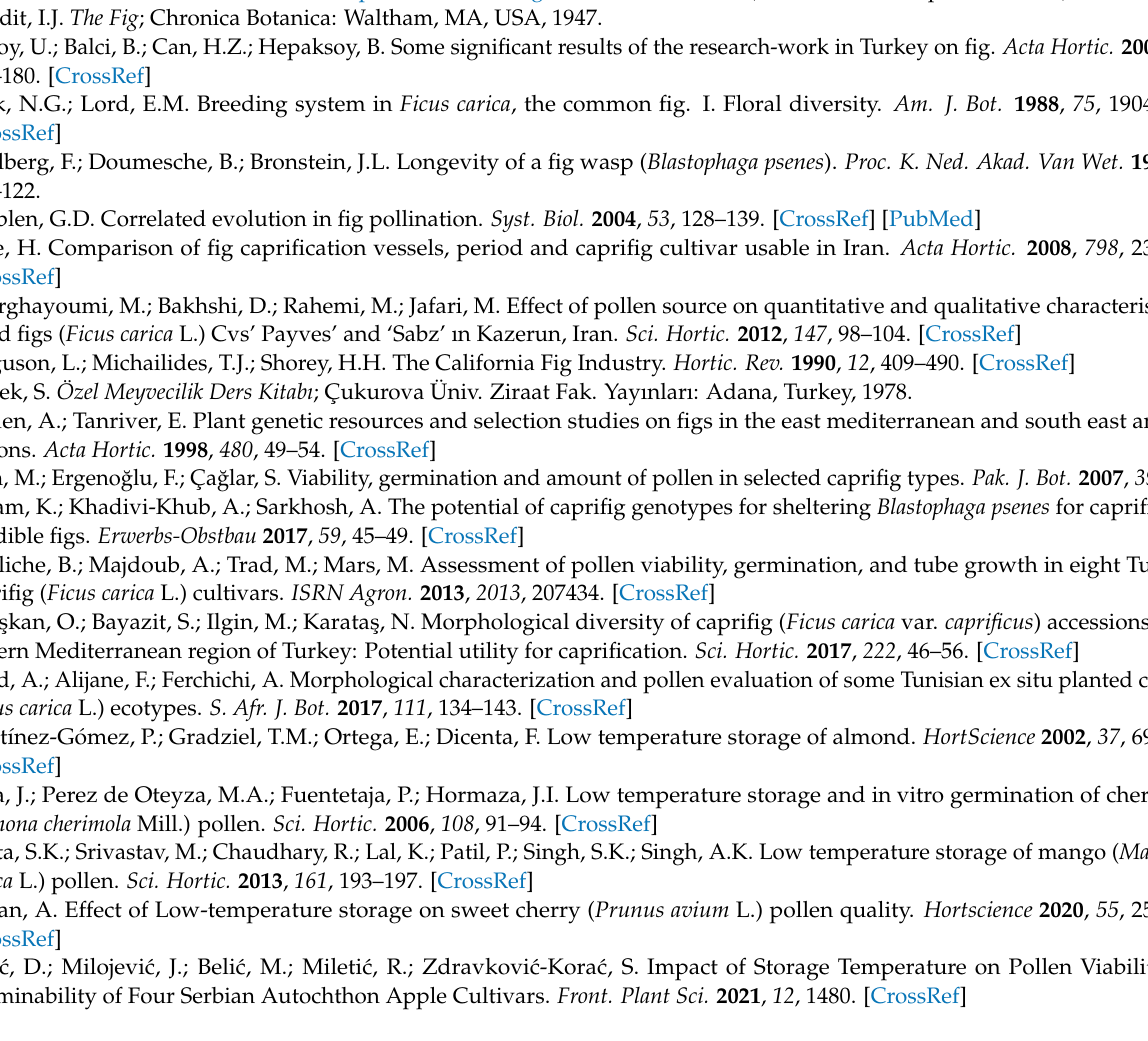
ostiole damage 1; Table S9: Analysis of variance for proportion of the ostiole damage 2; Table S10: Analysis of variance for flesh and skin thickness; Table S11: Analysis of variance for fruit cavity and fertile seeds per fruit; Table S12: Analysis of variance for proportion of the fruit cavity 1; Table S13: Analysis of variance for proportion of the fruit cavity 2; Table S14: Analysis of variance for single seed weight and sterile seeds; Table S15: Analysis of variance for fig endosepsis, SSC and TA; Table S16: Analysis of variance for proportion of time of ripening 1; Table S17: Analysis of variance for proportion of time of ripening 2; Table S18: Analysis of variance for skin color; Table S19: Analysis of variance for flesh